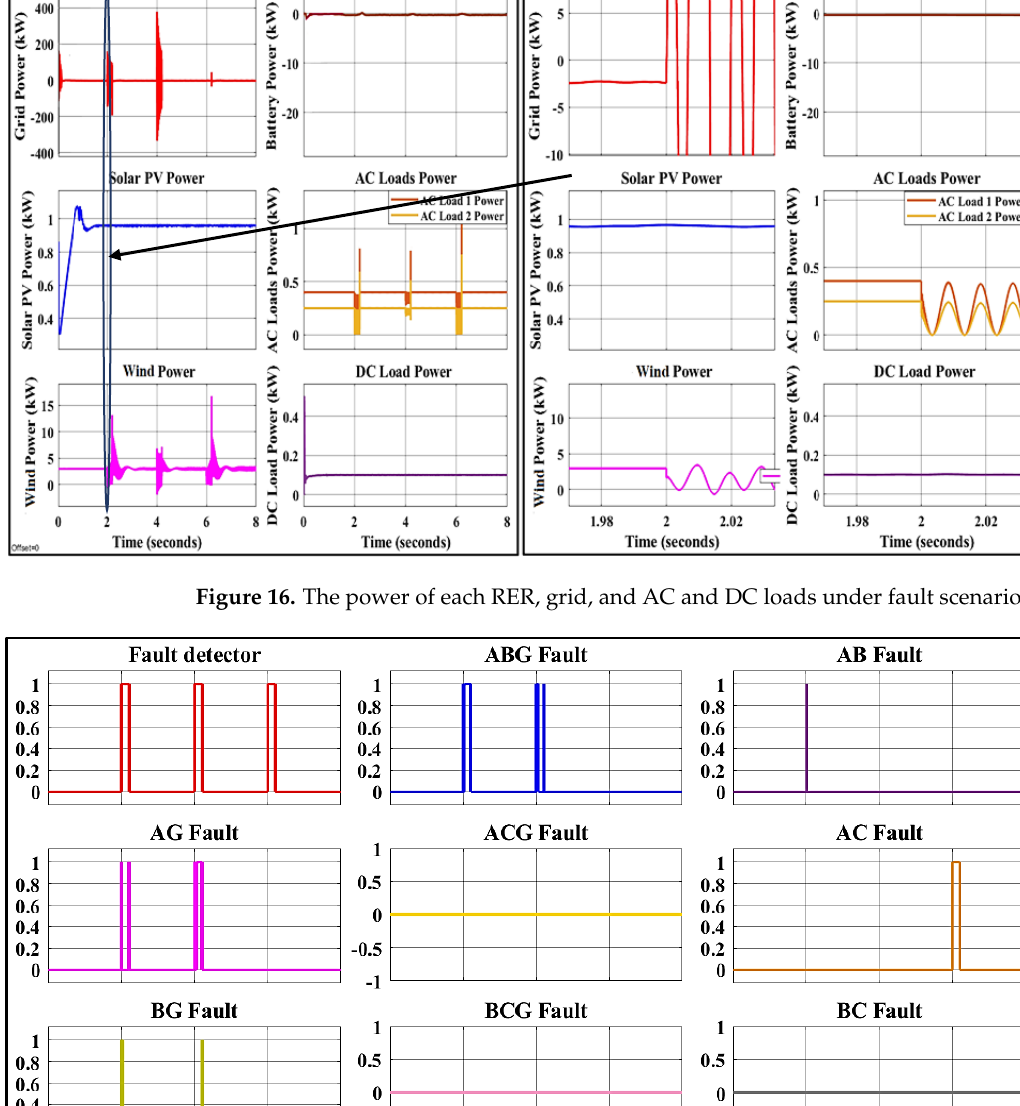
Figure 18. Fault location (Scenario 3, Case 1) . Figure 19. Fault location (Scenario 3, Case 2) .